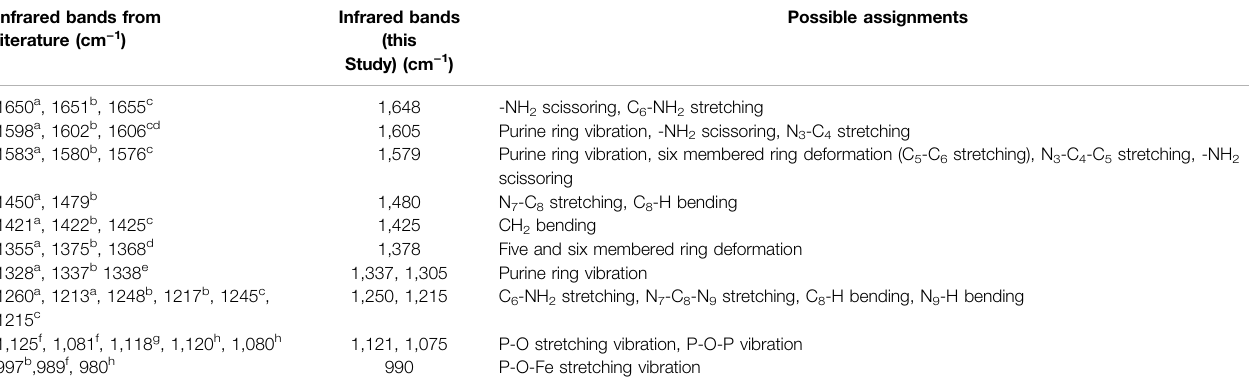
TABLE 1 | Infrared bands for adenosine-5 ′ -monopshophate from the literature and this study. Infrared bands from literature (cm − 1 )